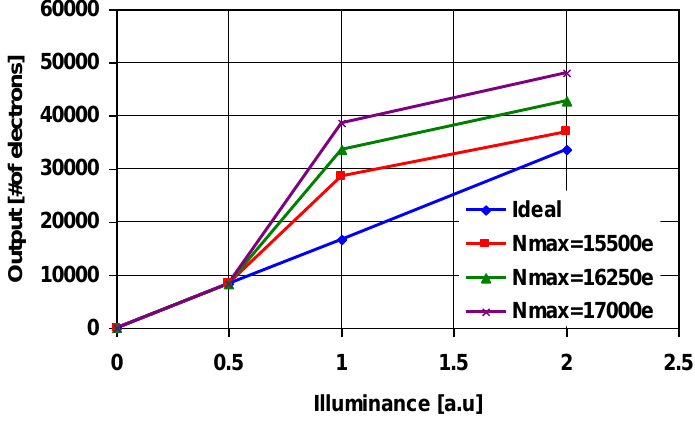
Figure 12. Photo-electric conversion characteristics of the synthesized wide dynamic range signals.